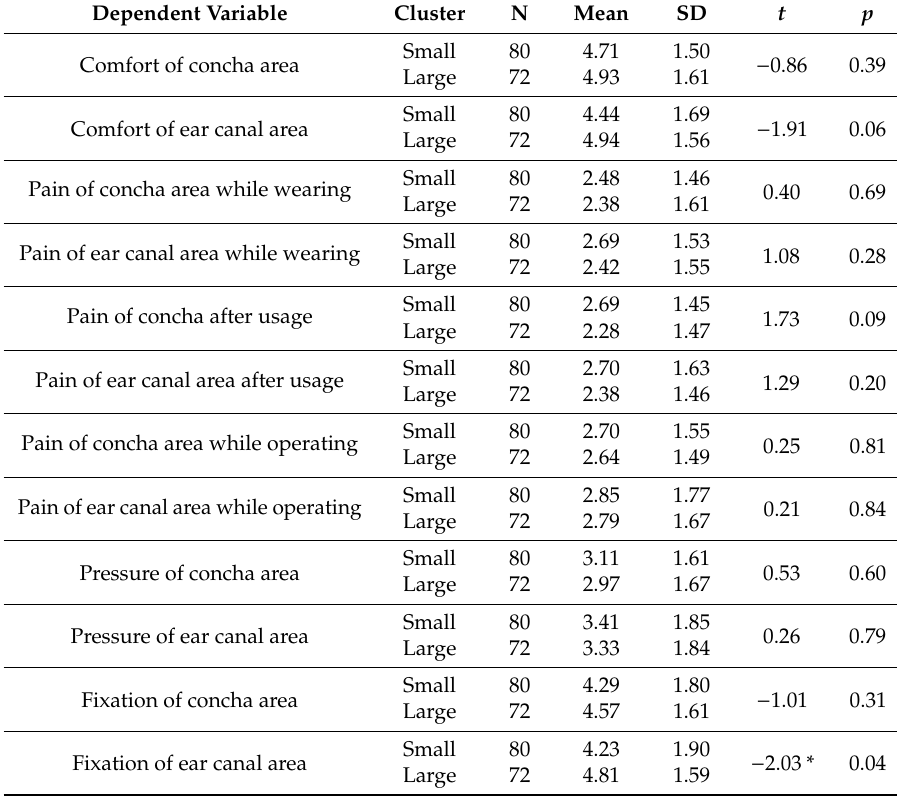
Table 13. Results of independent sample t -test for wearing comfort di ff erence according to incisura intertragica–antitragus length